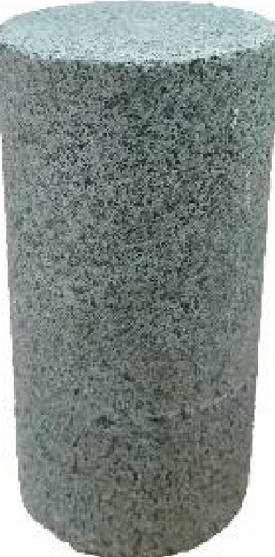
Figure 3: Tonalite specimen for uniaxial compression